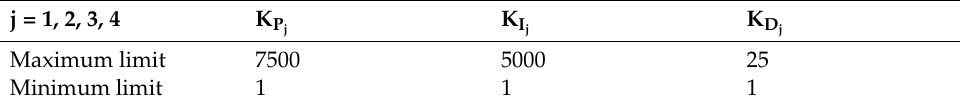
Table 5. The limits values of PID controllers’ parameters for Optimizer